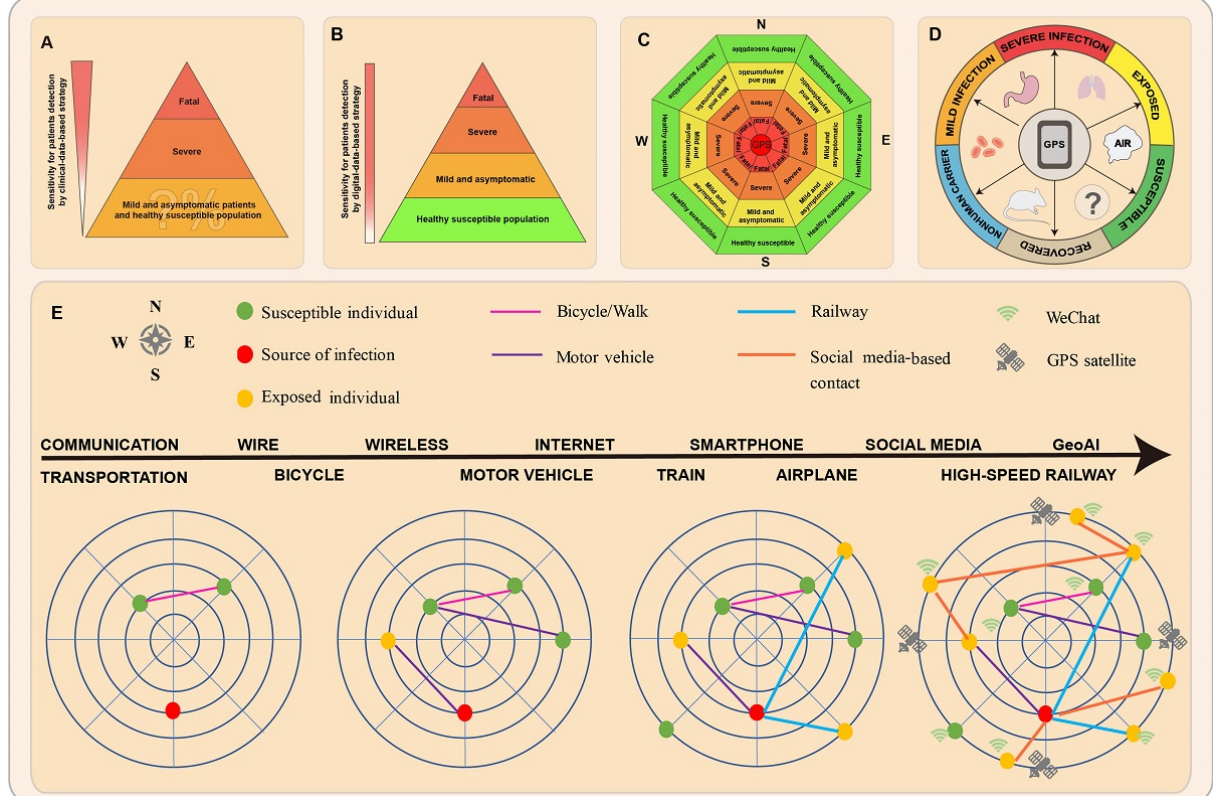
Figure 1. Comparison of patient-centered biomedical data-based strategy and digital data-oriented real time intelligent epidemic prevention and control strategy. GeoAI: geospatial artificial